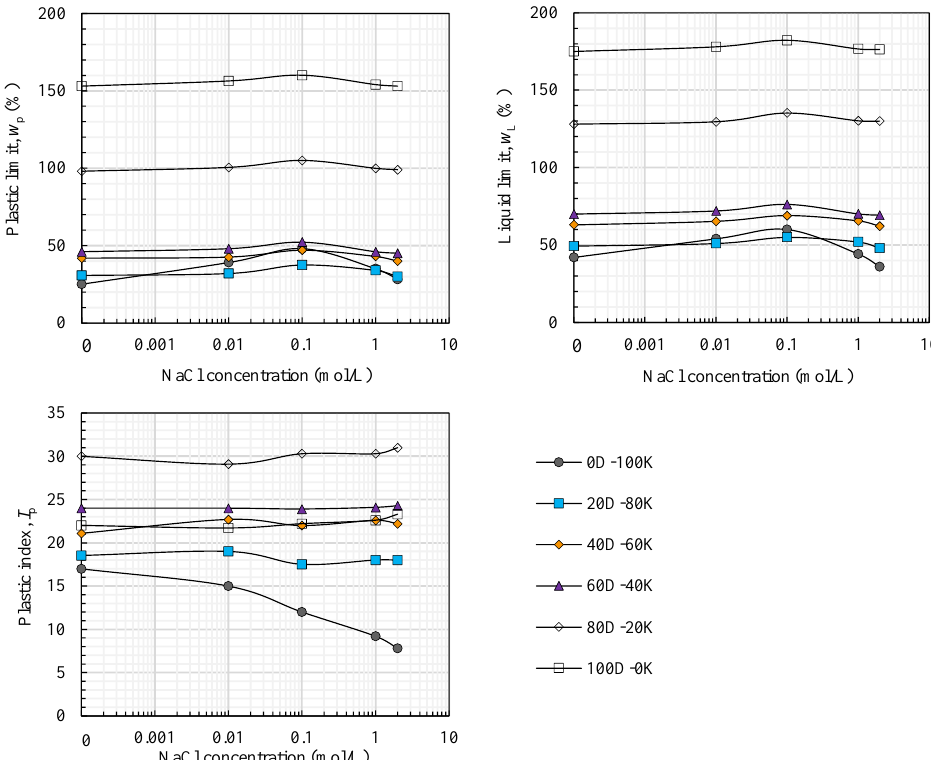
Figure 10. Values of w p , w L , and I P for DKM samples with different NaCl concentrations.